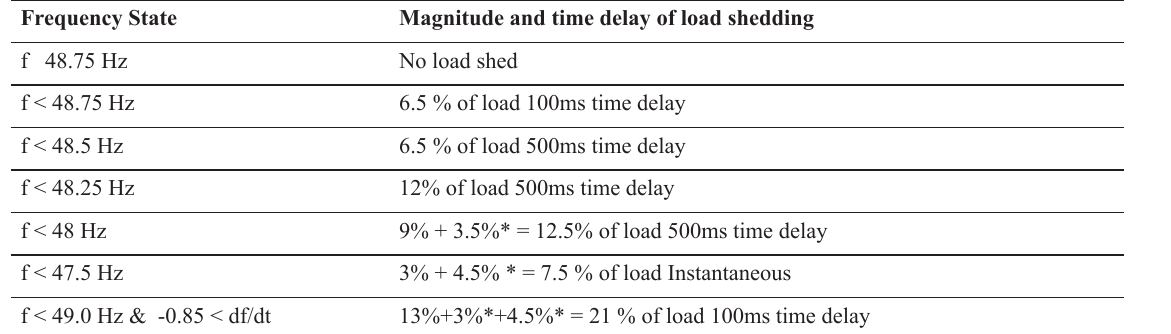
Table 4: Load Shedding Scheme used for the simulation model Frequency State